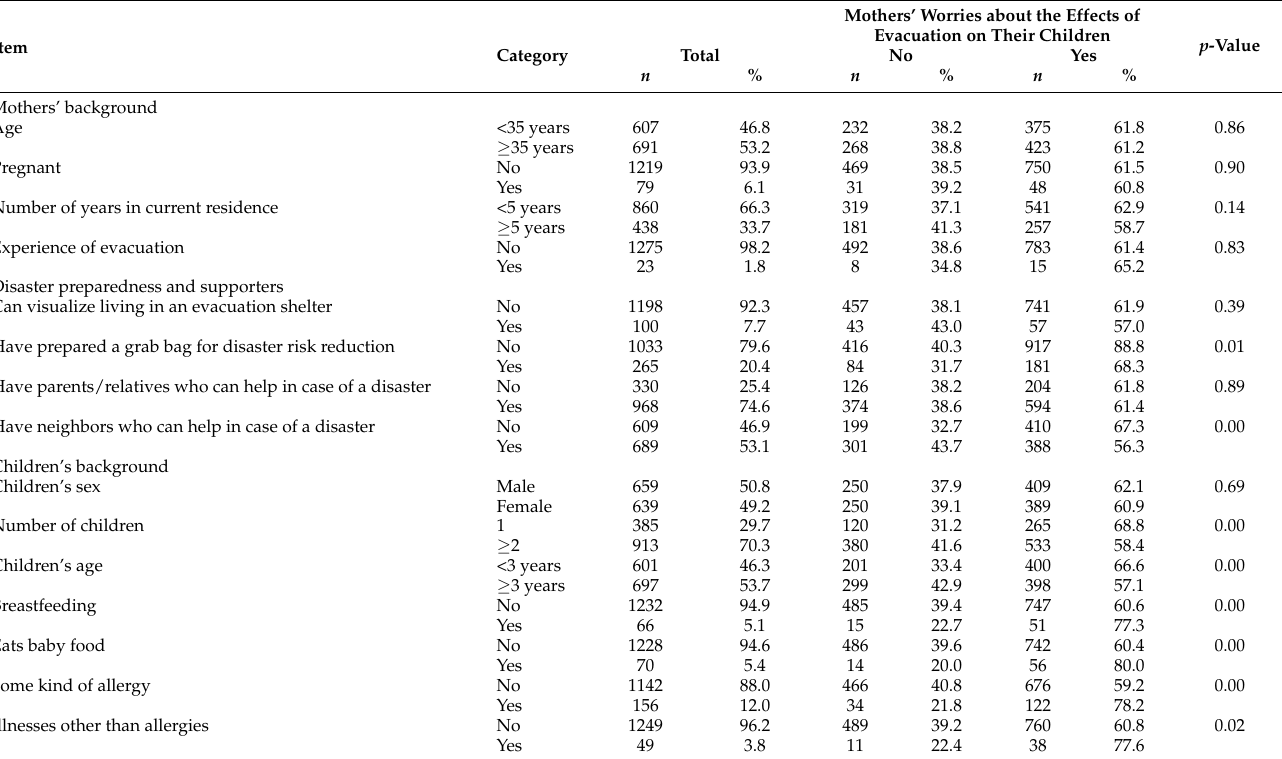
for disaster risk reduction ( n = 917, 88.8%; p = 0.01), having no neighbors to help in case of a disaster ( n = 410, 67.3%; p = 0.00), having one child ( n = 265, 68.8%; p = 0.00), having children under 3 years old ( n = 400, 66.6%; p = 0.00), breastfeeding ( n = 51, 77.3%; p = 0.00), having children who eat baby food ( n = 56, 80.0%; p = 0.00), having children with some kind of allergy ( n = 122, 78.2%; p = 0.00), and having children with an illness other than allergies ( n = 38, 77.6%; p = 0.02). Table 3. Mothers’ and children’s backgrounds and disaster preparedness in relation to mothers’ worries about effects of evacuation on their children ( n = 1298).